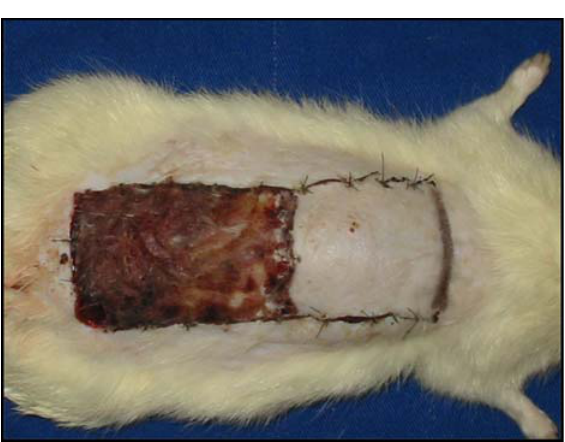
FIGURE 6 - Necrotic area - control group after seven days